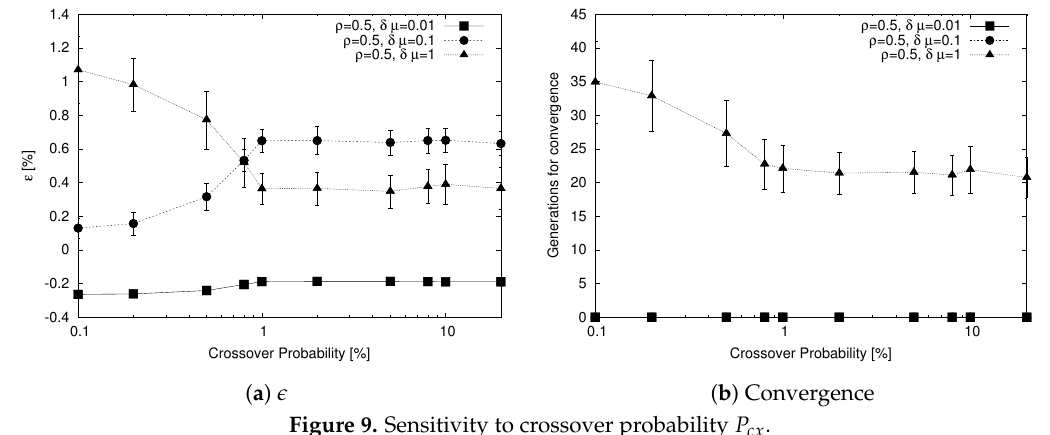
Figure 9. Sensitivity to crossover probability P cx